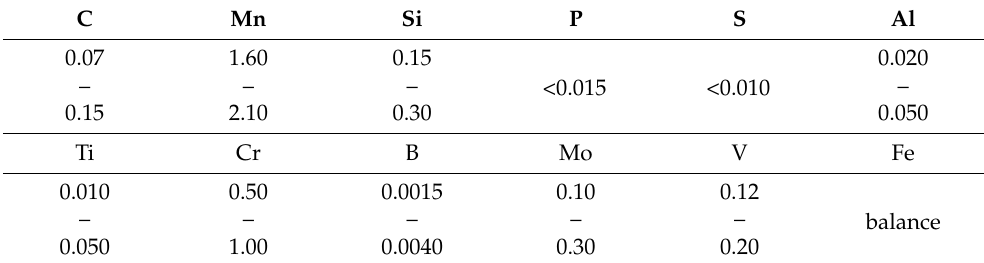
Table 1. Elemental composition of the steel substrates (1.7734.4) in wt% based on the material data